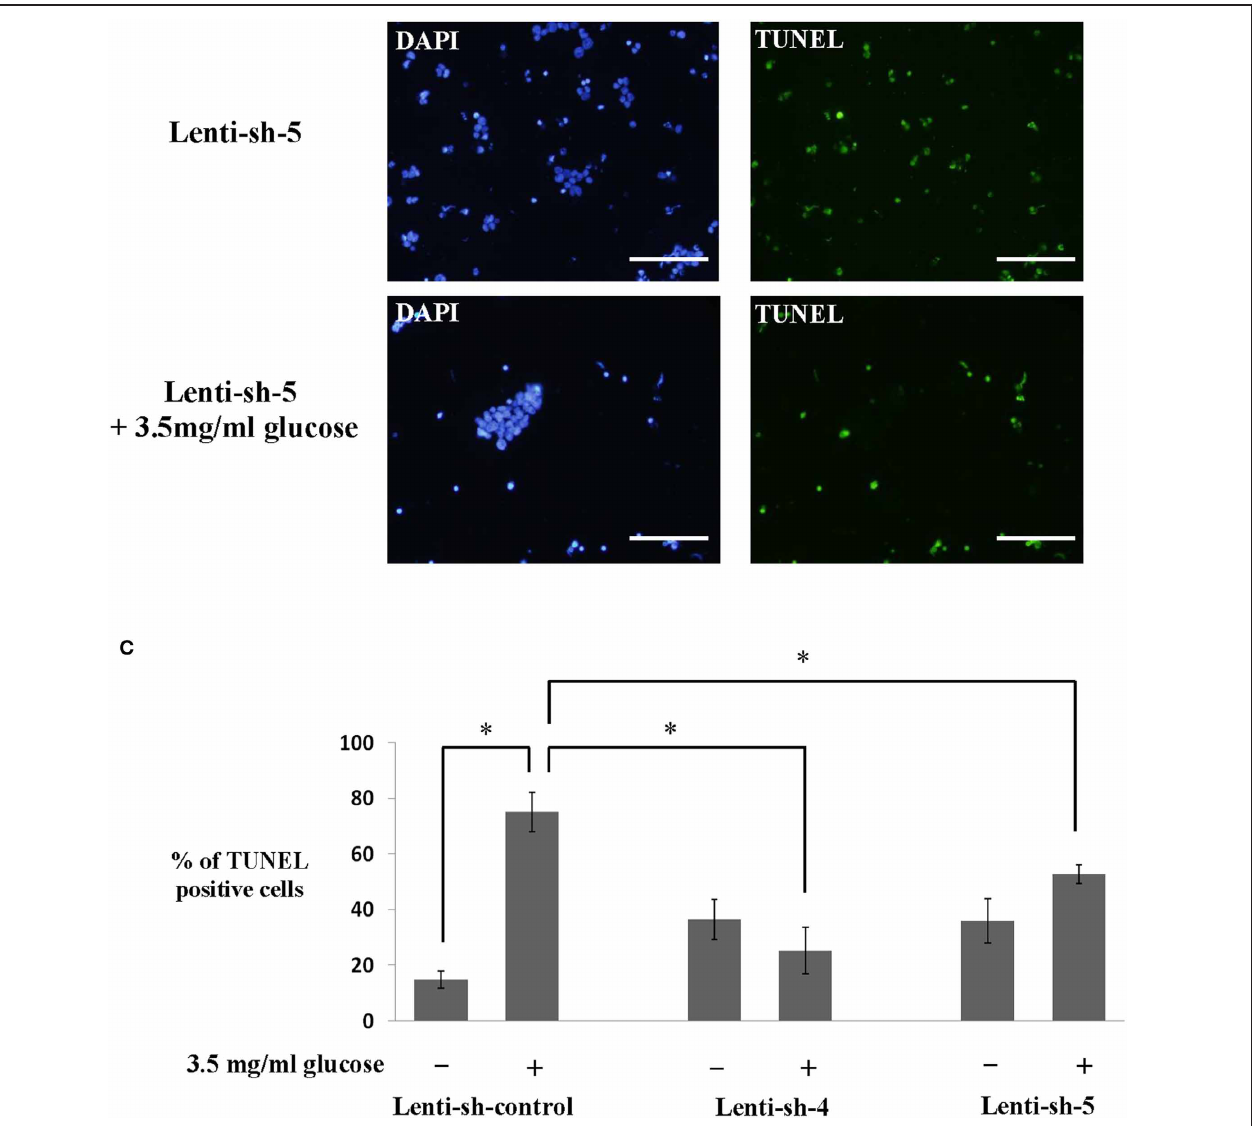
FIGURE 6 | Inhibiting AChE protein expression by different sh-RNA sequences reduces apoptosis in Y79 cells treated with glucose. (A) Y79 sh-RNA lenti-infected and selected cells (as described under Materials and Methods), were pre-treated in starvation medium containing 1% FBS and 1mg/ml of glucose for 16–24h and then treated with 3.5mg/ml glucose for 1h except for sh-control in lane 1. Cytoplasmic extracts were prepared and run for western blot analysis to detect AChE expression or anti α -Tubulin (for loading control) as described under Materials and Methods. The sample in lane 1 and those in 2–7 were run in separate lanes on the same gels. The